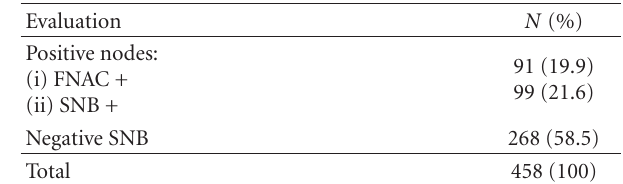
Table 3: Axillary nodes